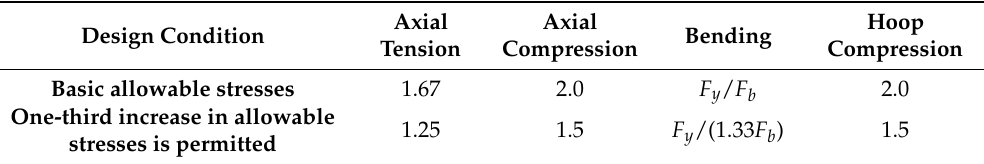
Table 11. Safety factors of Working Stress Design